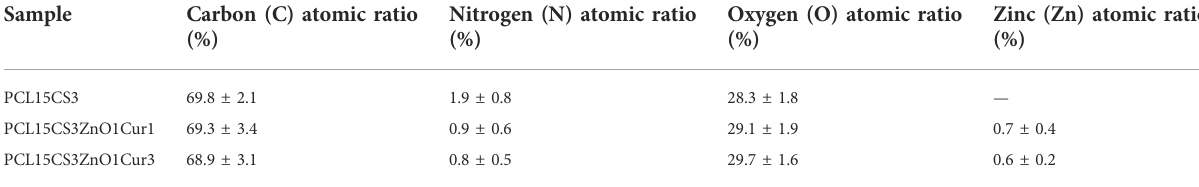
TABLE 2 Data of the elemental analysis of the electrospun samples.